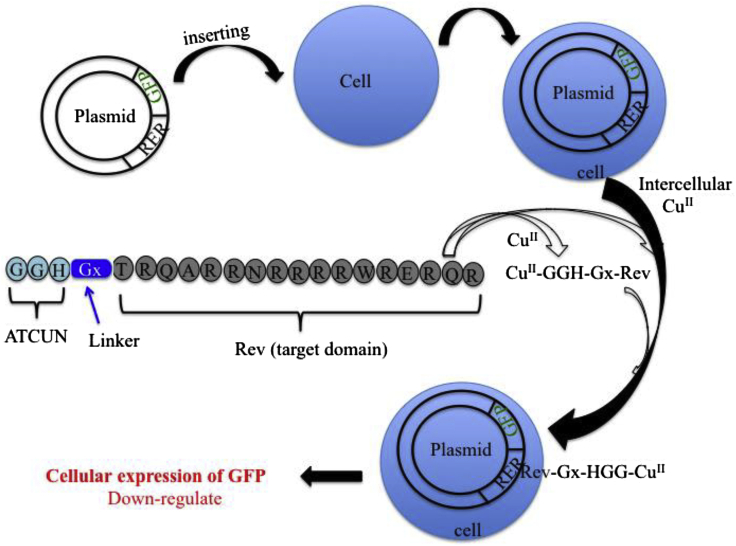
Schematic Representation of the Cellular Expression of GFP (Plasmid Encoded GFP-RRE) Is Induced by CuII-ATCUN-Rev(Modified from Hocharoen and Cowan, 2009).